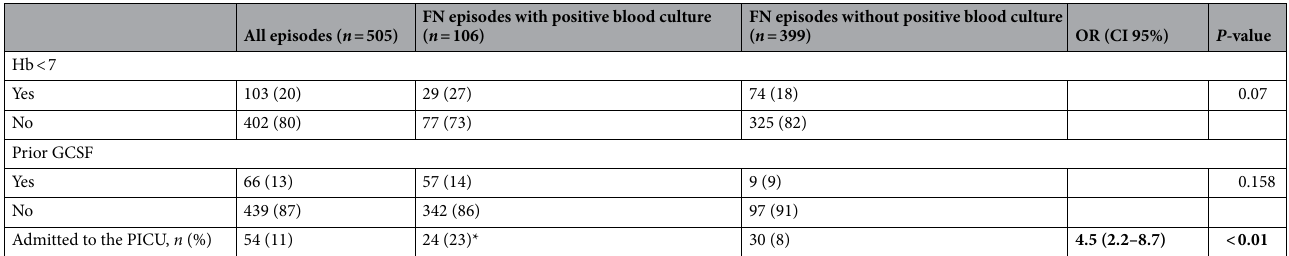
Table 1. Characteristics of FN episodes among pediatric cancer ( N = 505). * P < 0.05 compared to patient admission that did not develop positive blood culture, ** VURI viral upper respiratory infection documented by RVP , ***includes subjective symptoms such as vomiting, diarrhea, or abdomen pain.